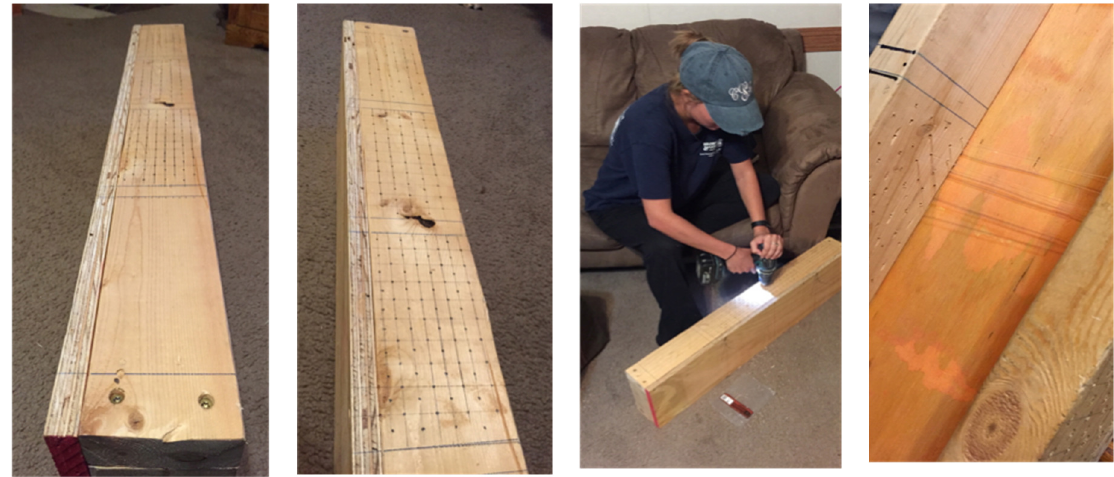
Fig. 7: Process of Marking, Drilling, and Stringing the Fiber Optics through the